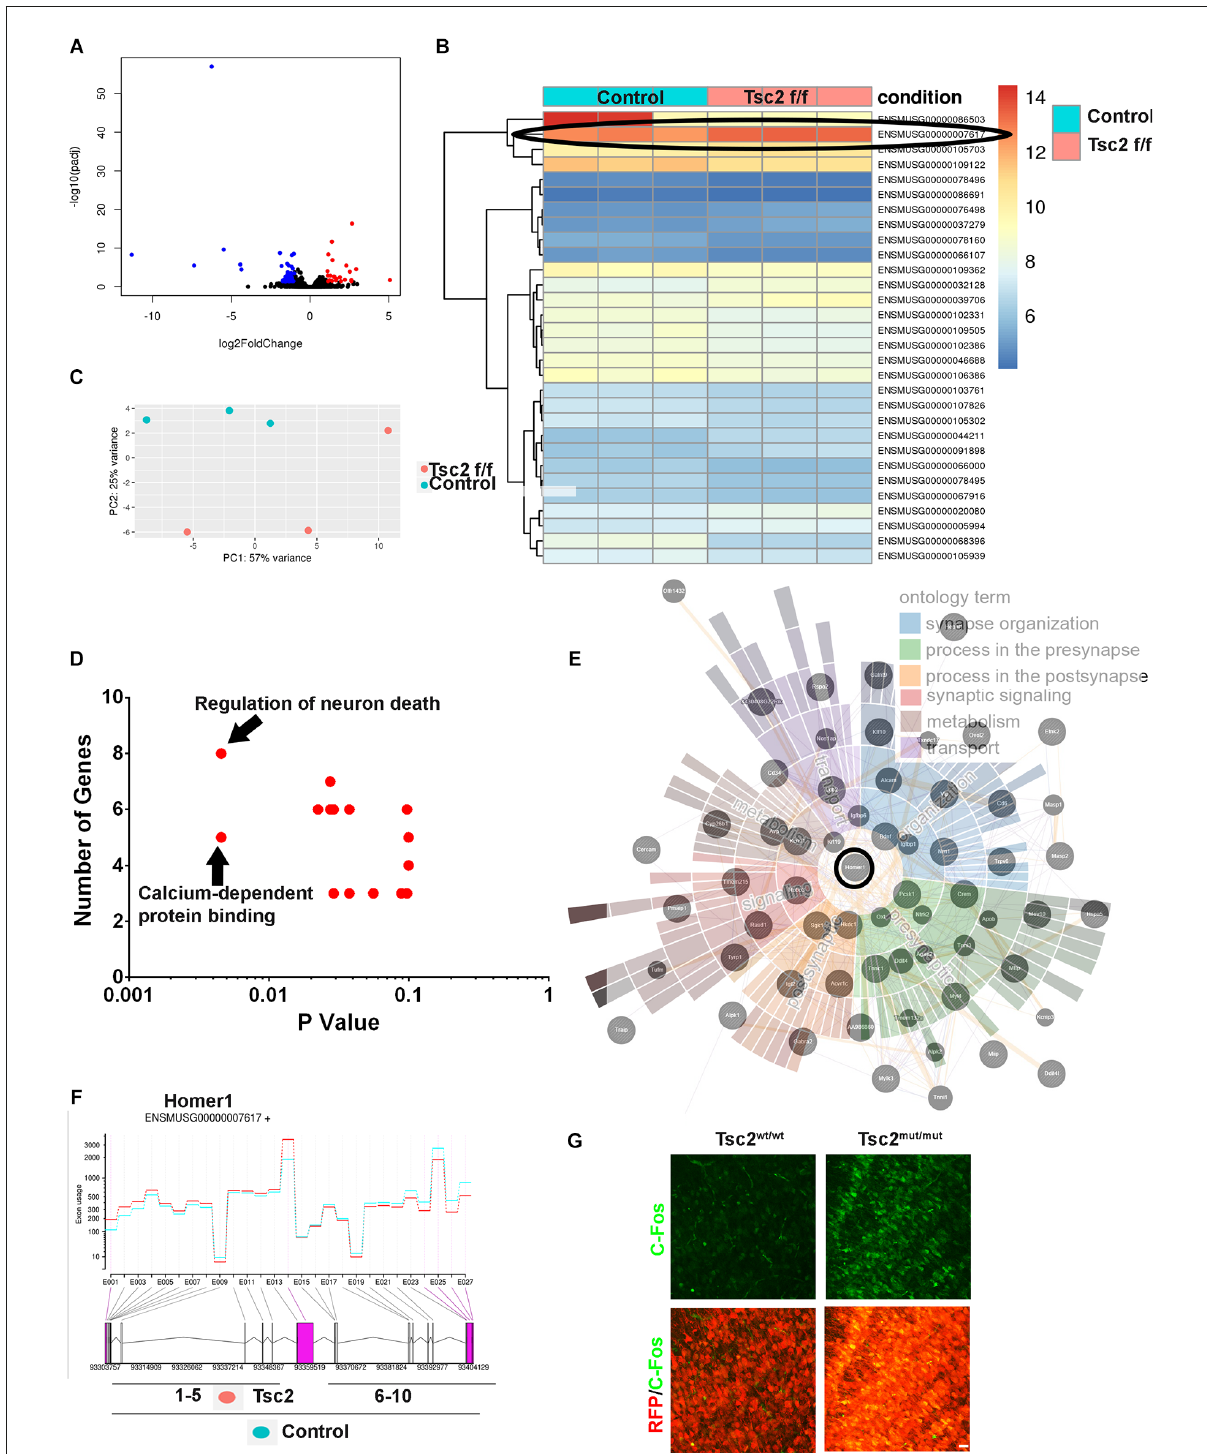
FIGURE8 RNA sequencing reveals mechanistic insight into neural circuitry. (A) Volcano plot of RNA-seq of Tsc2 wt/wt and Tsc2 f/f OBs. (B) Heat map of RNA-seq data from Tsc2 wt/wt and Tsc2 f/f . (C) PCA analysis of Tsc2 wt/wt and Tsc2 f/f OB RNA-seq data with (ENSMUSG000000007617=Homer1) circled. (D) GO terms listed based on P-values and the total number of transcripts represented in terms are differentially represented. (E) Network analysis of differentially expressed transcripts with Homer1 circled and SynGo terms overlapping network nodes. (F) Differential exon use mapping indicating Homer1a RNA transcripts is increased following Tsc2 deletion compared to controls. (G) C-Fos staining in Tsc2 wt/wt or Tsc2 f/f OB GC